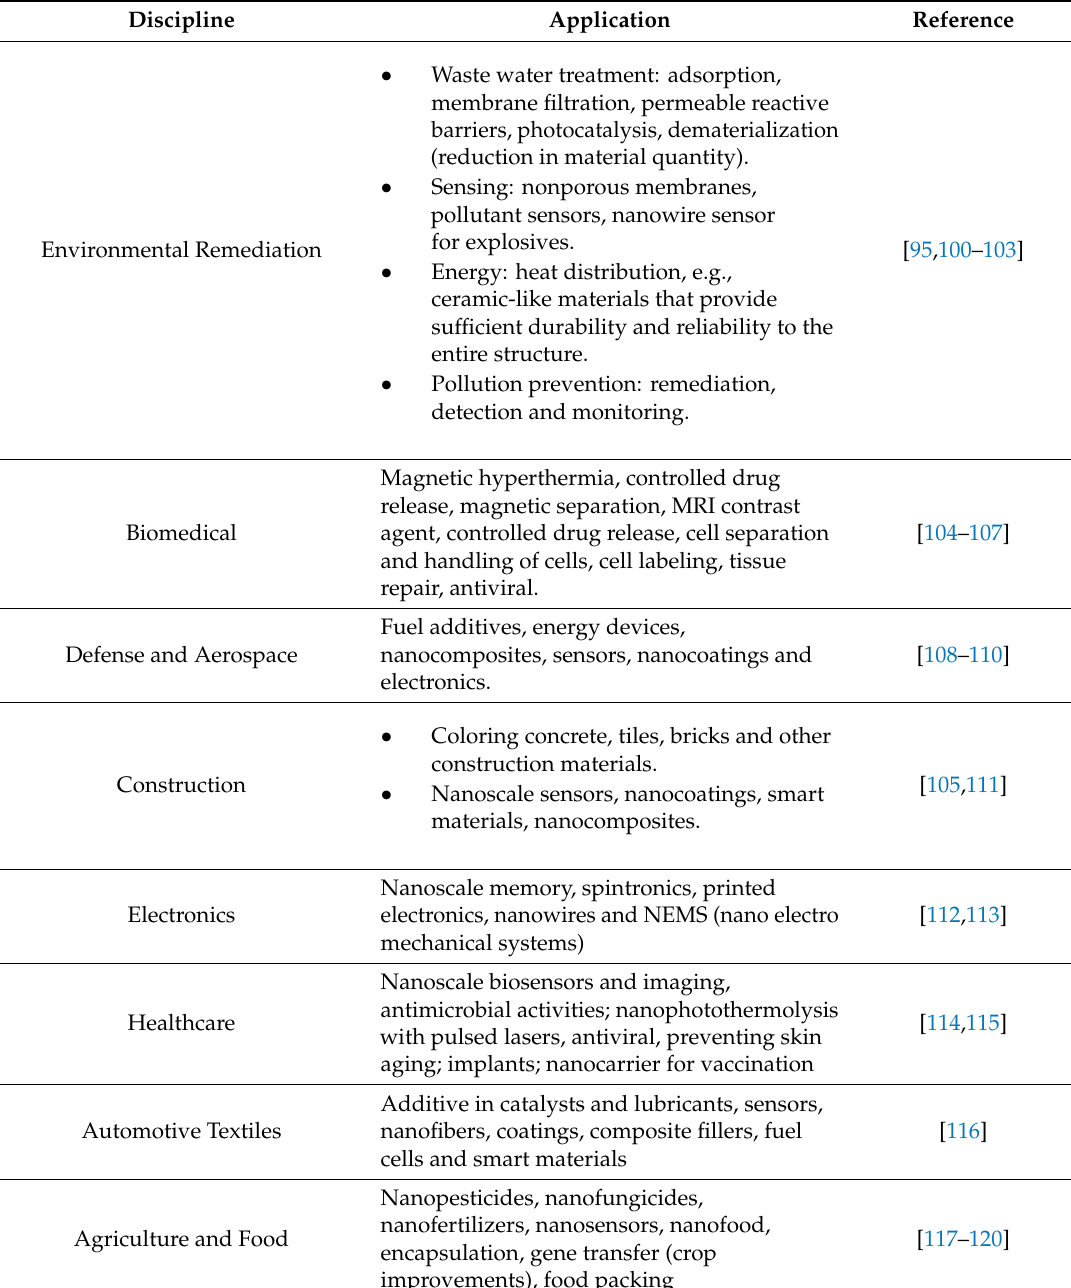
Table 4. Di ff erent areas of application of magnetic